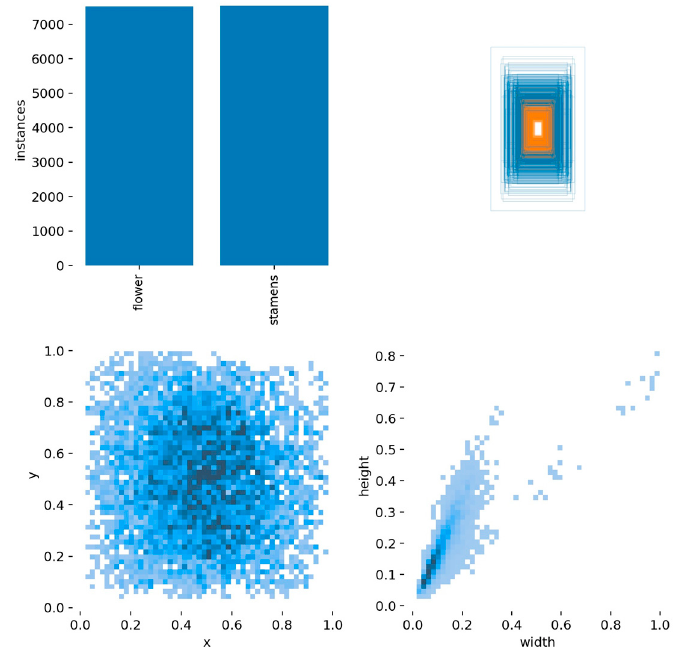
Figure 12. Label information distribution.